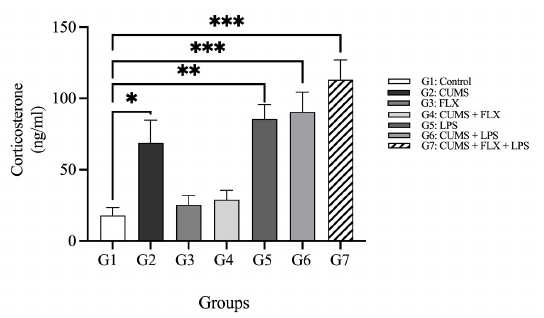
Figure 7. Effect of Lipopolysaccharide on Serum Corticosterone Levels in Fluoxetine Treatment Resistant Depressive Rats: Schematic represents corticosterone level (ng/mL) in animal groups exposed to various treatment. Data are expressed as the means ± SEM; n = 5. Group comparisons were performed using one-way ANOVA followed by a Turkey–Kramer post hoc test; * p < 0.05; ** p < 0.01; *** p < 0.001. CUMS: chronic unpredictable mild stress; FLX: fluoxetine; LPS: lipopolysaccharide.